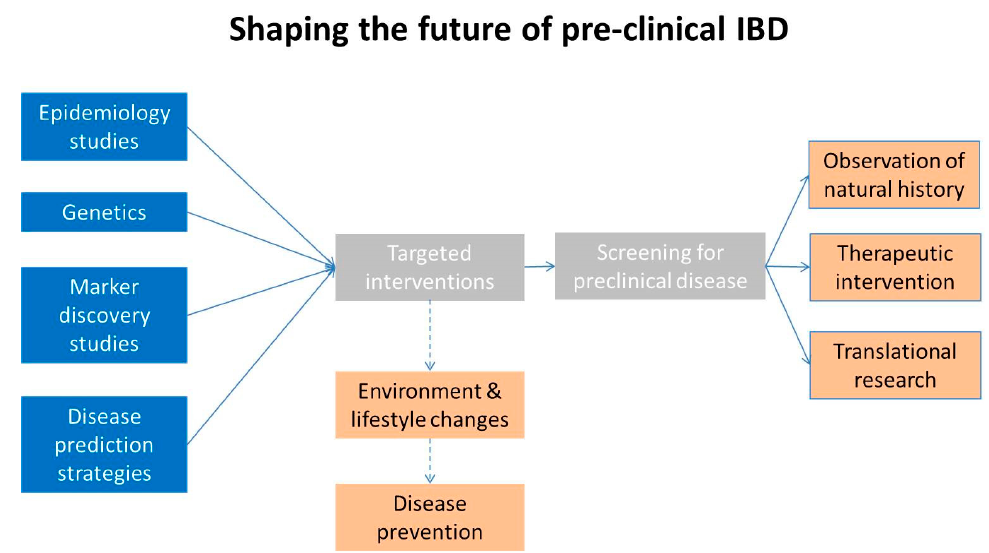
Figure 5. The future state of pre-clinical IBD. Ongoing epidemiology and marker discovery studies as well known genetic alterations and disease prediction strategies could lead in the future to specific intervention to reduce or eliminate environmental factors and eventually to disease prevention. In the foreseeable future they might allow the selection of individuals at risk for developing the disease who can be subjected to screening by imaging. Once a population with biologic onset-IBD is identified observational, therapeutic and translational studies could be performed.